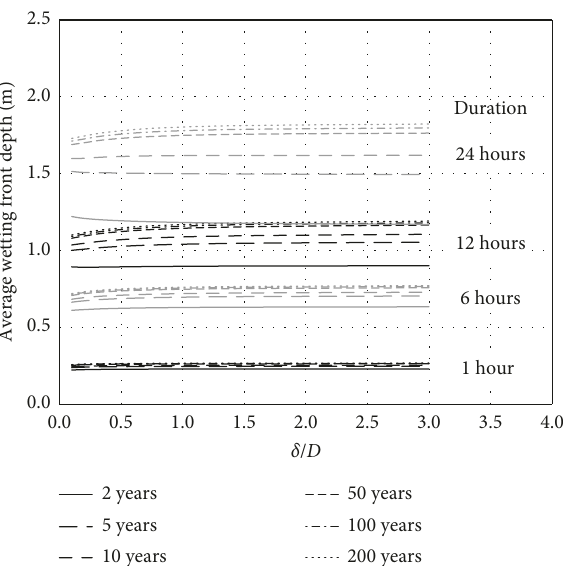
Figure 10: Change in wetting front depth depending on rainfall duration and normalized SOF.